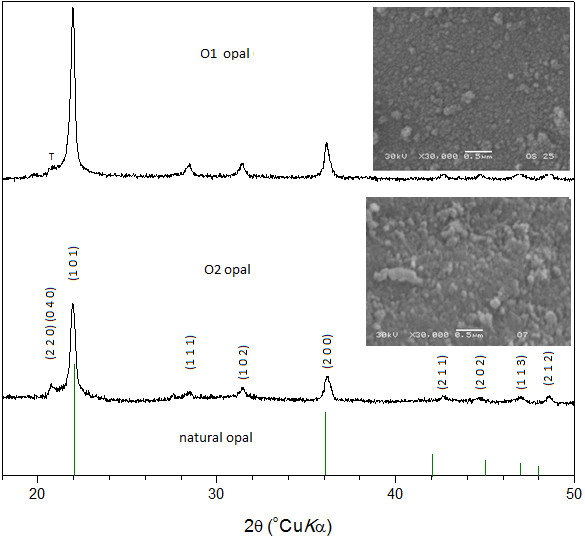
XRD pattern and SEM micrographs of O1 and O2 opals. The lines present the band features of natural opal as reference and peaks marked T to tridymitic stacking.